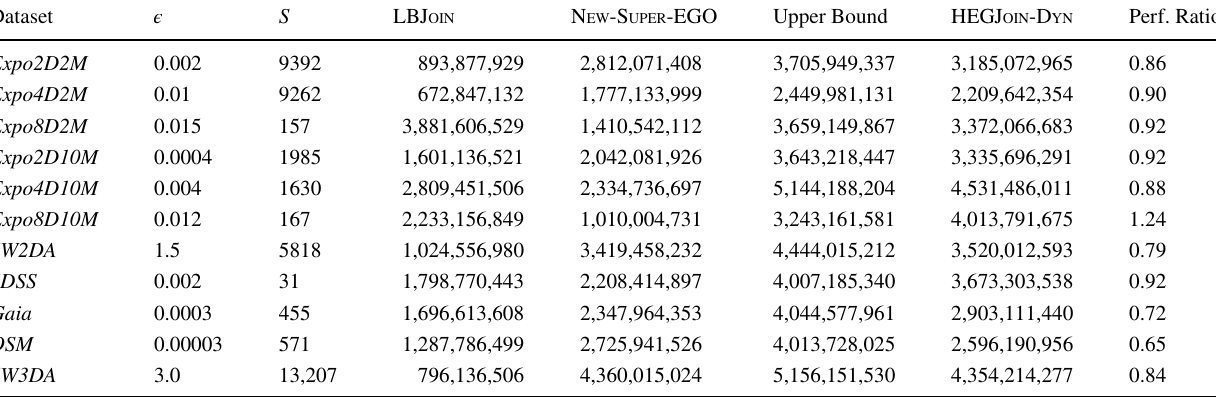
Table 4 Throughput of candidate points refined (candidates/s) by LBJ oin , n Ew -S upEr -EGo , the upper bound of LBJ oin plus n Ew -S upEr -EGo , HEGJ oin -d yn , and the performance ratio between HEGJ oin -d yn and the upper bound across several datasets. Results from Platform 1